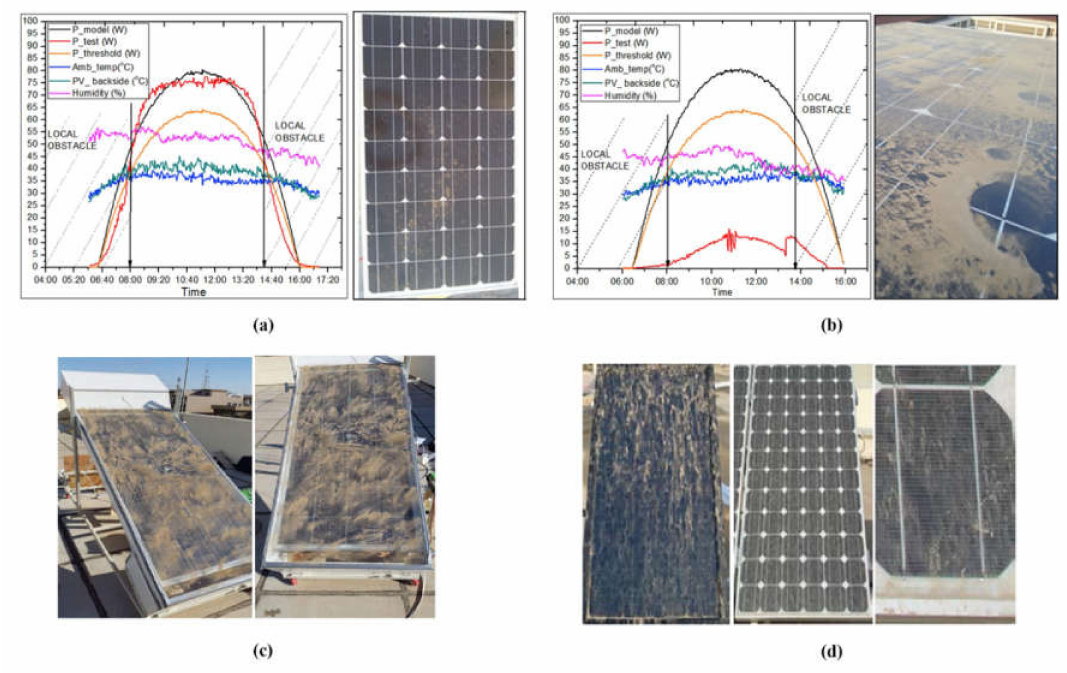
Figure 2. Photovoltaic (PV) output power ( a ) after one week of dust accumulation and ( b ) after three weeks in September 2014, Surabaya, Indonesia [71]. ( c ) Adverse e ff ect of soiled PV / thermal (T) system in Iraq [87]; ( d ) accumulated dust on di ff erent PV modules installed in Kuwait